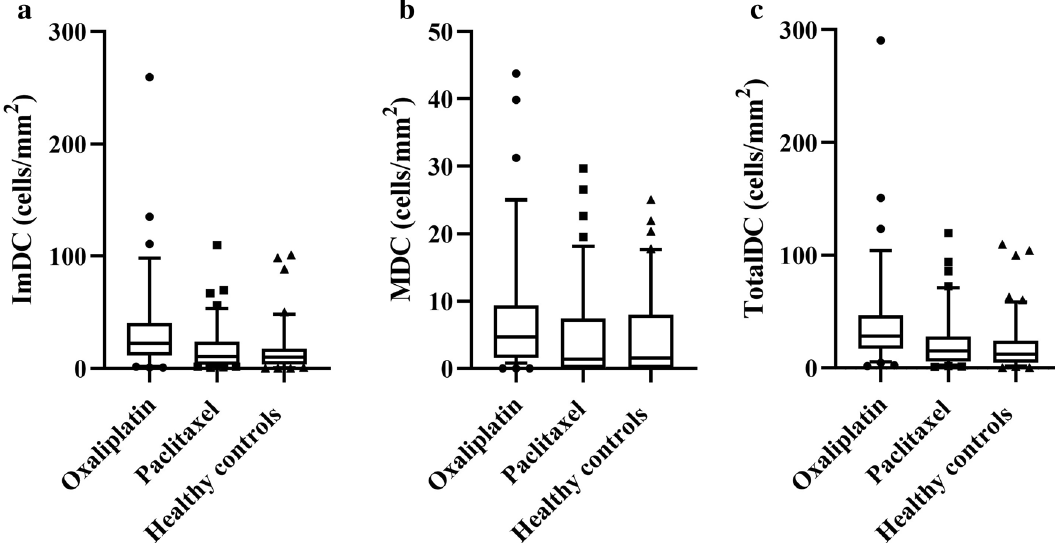
Figure 2. Dendritic cell density comparisons. Boxplots and whiskers representing the 10th to 90th percentile of ( a ) immature dendritic cell density (ImDC), ( b ) mature dendritic cell density (MDC), and ( c ) total dendritic cell density (TotalDC) in patients treated with paclitaxel or oxaliplatin and healthy controls.